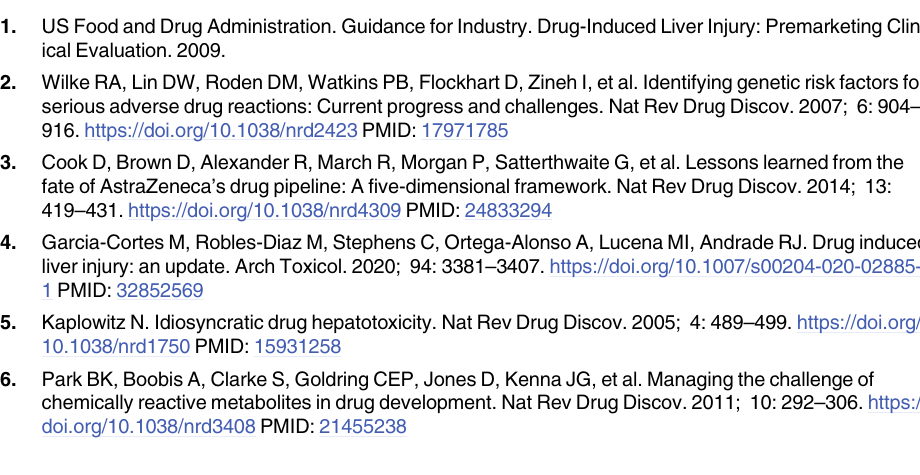
S1 Table. The list of target compounds used. S2 Table. The list of chemical descriptors used. S3 Table. The list of newly approved drugs used and their AMW